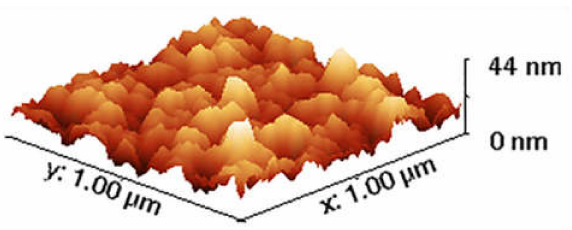
Figure 7. A typical AFM image of the surface roughness of a SiO 2 layer deposited by PECVD process.